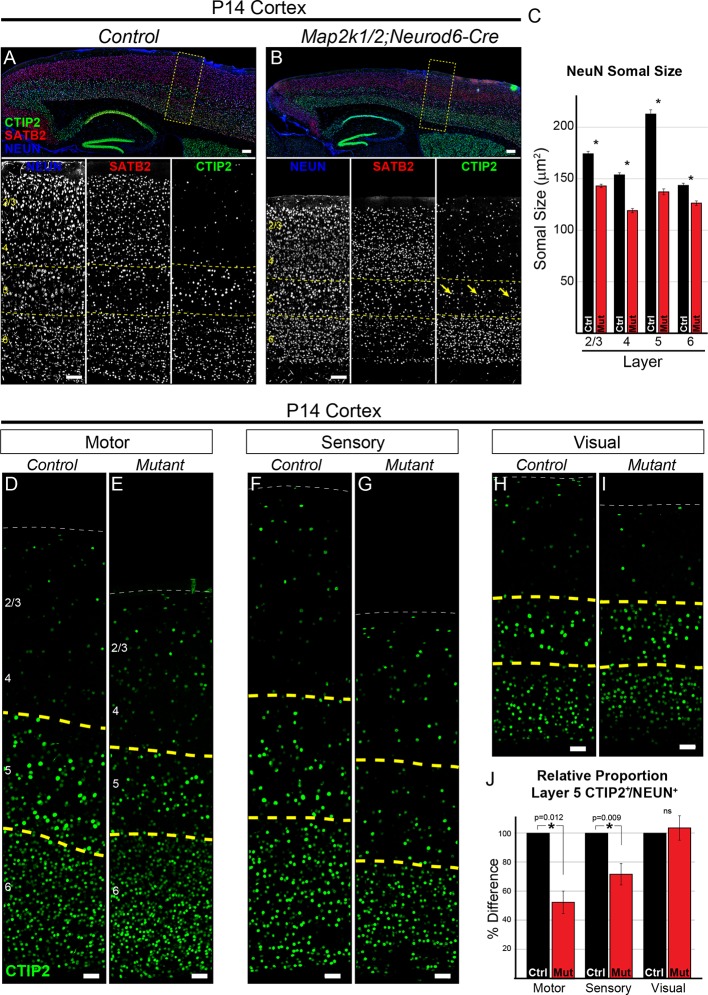
Loss of ERK/MAPK signaling leads to a reduction in the number of CTIP+ layer 5 neurons and reduced neuronal somal size.(A–B). Immunostaining of P14 control (A) and Map2k1/2;Neurod6-Cre (B) sagittal forebrain sections for all neurons, callosal projection neurons, and subcortical projection neurons with NEUN, SATB2, and CTIP2, respectively, revealed an aberrant pattern of CTIP2 expression in layer 5 of mutant sensorimotor cortices (yellow arrows) (n=6, scale bar=100 µm). (C) Quantification of somal size was performed by measuring the cross-sectional area of randomly selected, NEUN labeled soma in distinct cortical layers. A reduction in the size of NEUN labeled soma in P14 mutant sensory cortices was detected in all cortical layers, but was particularly pronounced in layer 5 (n= >300 total neurons per layer derived from five independent mice per condition, mean ± SEM, *p<0.001). (D–I) Representative confocal images of CTIP2 immunolabeling in radial columns of primary motor (D–E), sensory (F–G), and visual (H–I) cortex from P14 control (D, F, H) and Map2k1/2;Neurod6-Cre (E, G, I) brains (scale bar=30 µm). (J) Quantification of the relative number of layer 5 CTIP2+ neurons as a proportion of the total number of NEUN+ neurons in a cortical column revealed a substantial decrease in motor and sensory, but not visual, cortices in P14 mutant mice (n=4, mean ± SEM, *p<0.05).